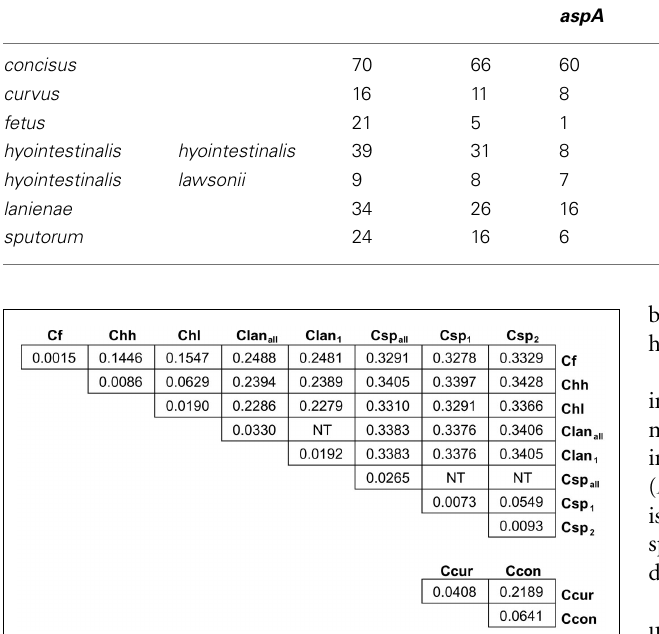
Table 3 | Sequence types and alleles identified by the novel MLST methods. Species Subspecies